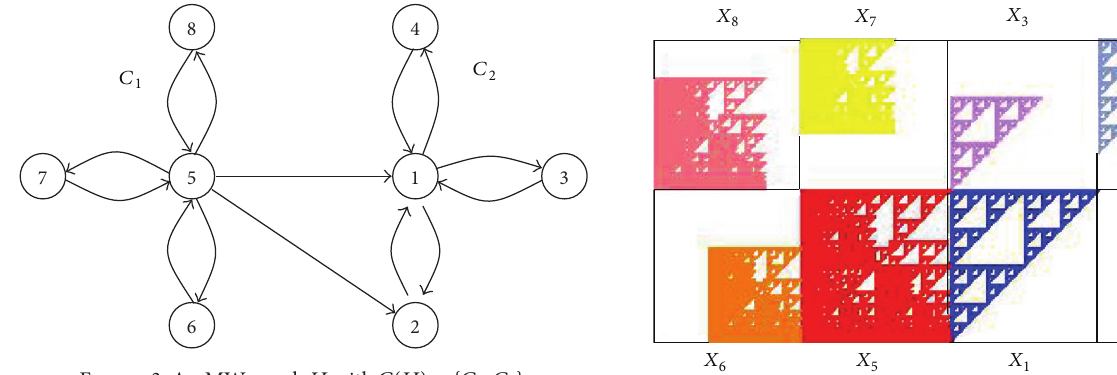
Figure 3: An MW-graph 𝐻 with 𝐶(𝐻) = {𝐶 1 ,𝐶 2 } .